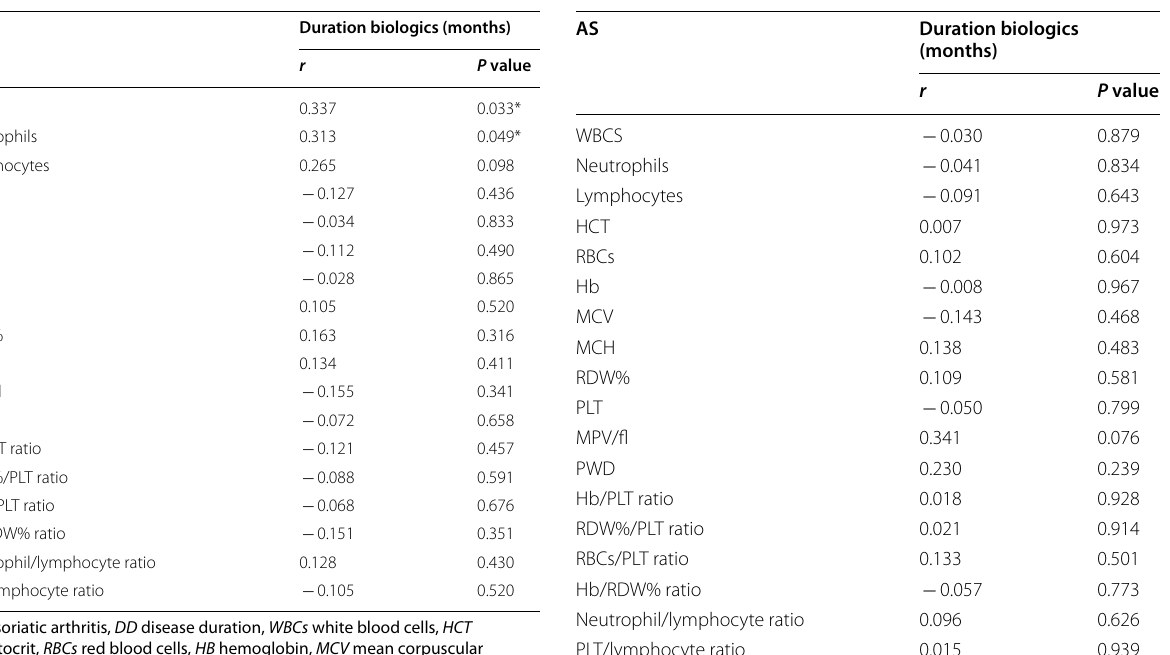
Table 7 Correlation between the WBCs, RBCs and Platelets indices with duration of biologic therapy